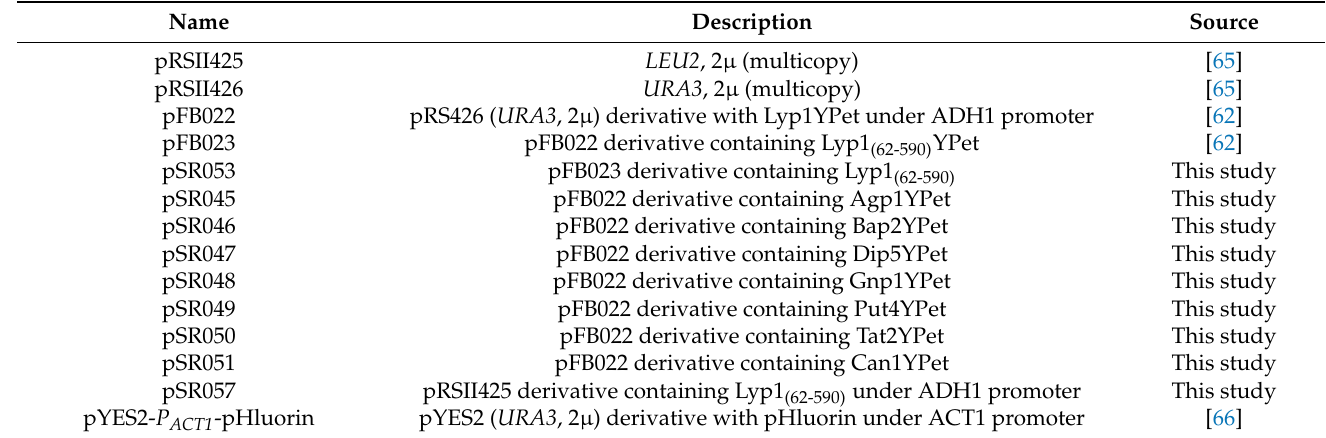
Table 2. Plasmids used in this